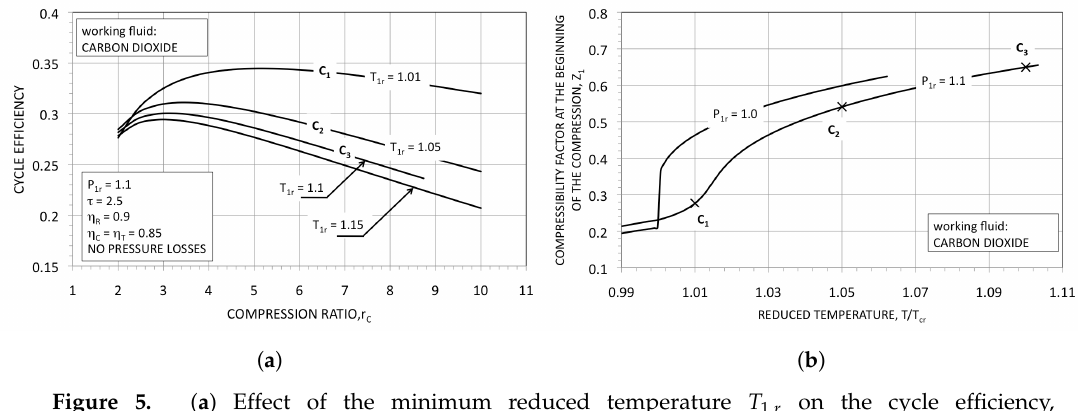
Figure 5. ( a ) Effect of the minimum reduced temperature T 1, r on the cycle efficiency, and ( b ) compressibility factor in the point 1 (at the beginning of the compression). The minimum reduced pressure P 1, r and the temperature ratio τ are